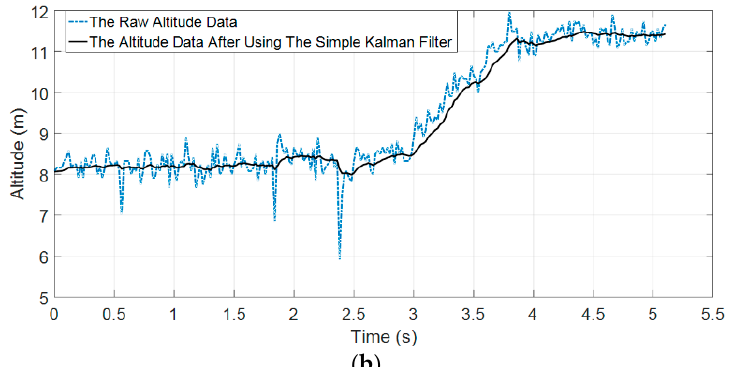
Figure 13. The loss of physical performance because of moving up in an elevator; ( a ) the RMS of accelerometer data; ( b ) the barometric data.